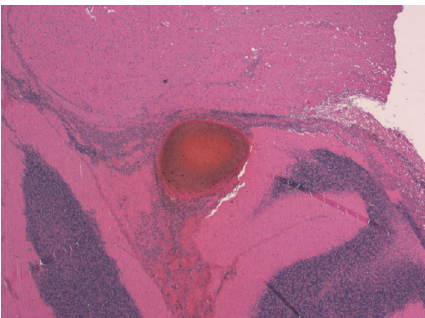
Figure 2: Large vascularthrombus in the cerebellum(H & E, ∗